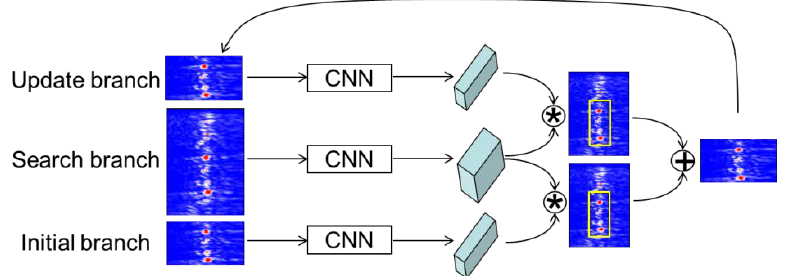
Figure 3. Structure of the triple velocity spectrum tracking network.